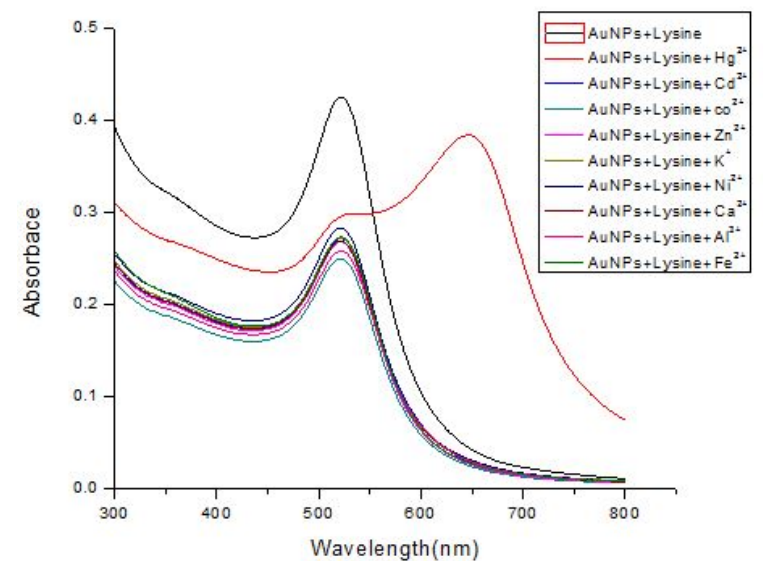
Fig 4. Selectivity of the colorimetric response for Hg 2+ analysis